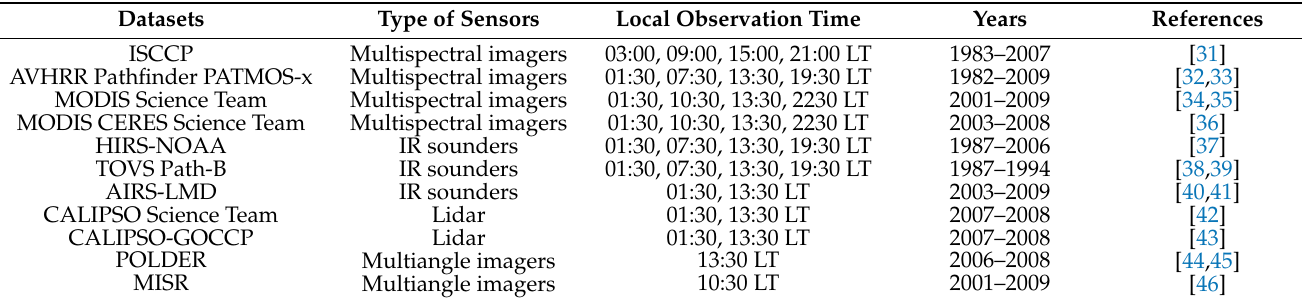
Table 1. Description of the GEWEX Cloud Assessment datasets used in this study. Datasets Type of